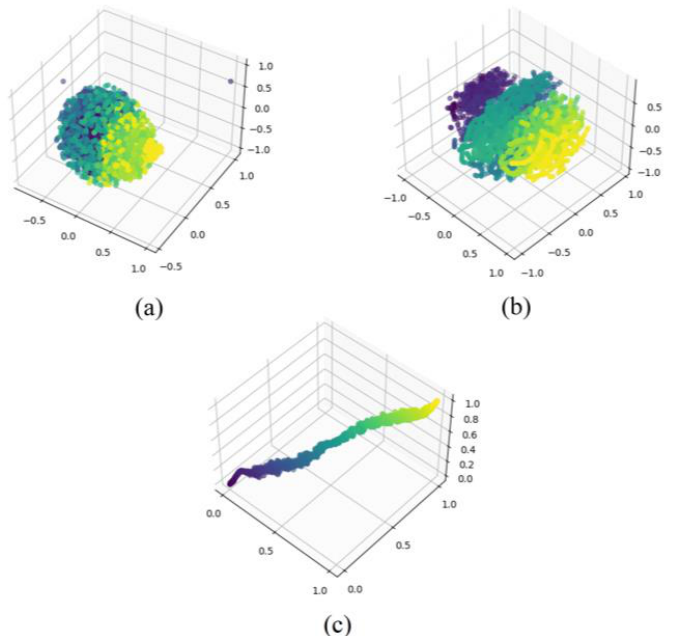
Figure 12. Comparison of ablation study. ( a ) The HI of training bearing 1_1 under three test conditions, ( b ) the loss of training bearing 1_1 under three test conditions.